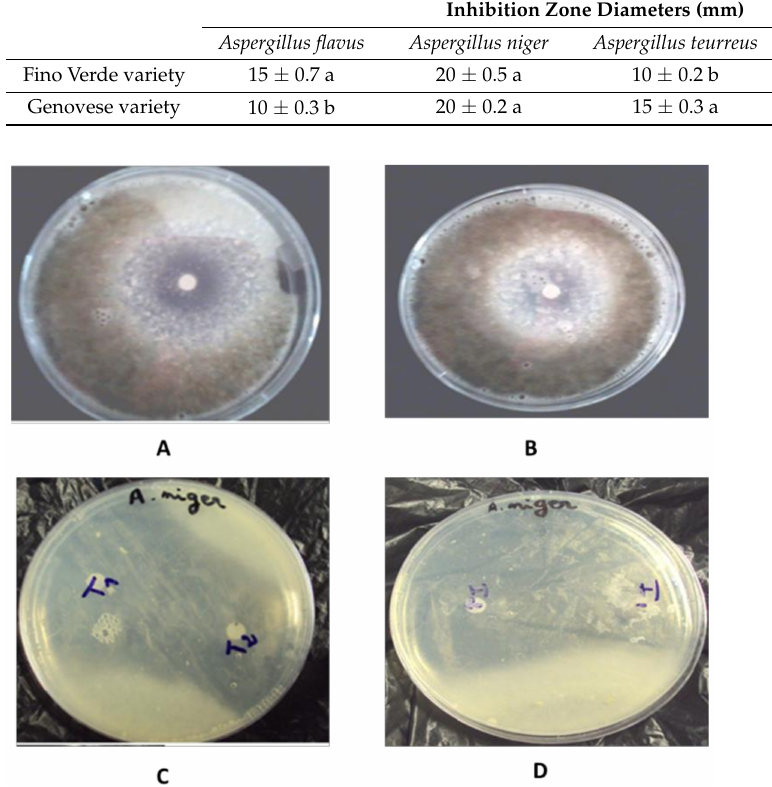
Figure 2. Activity of EO of O. bacilium : ( A ): Activity of EO of Fino Verde variety against A. carbonarius , ( B ): activity of EO of Genovese against A. carbonarius , ( C ): Activity of EO of Fino Verde variety against A. niger , ( D ): activity of EO of Genovese variety against A. niger